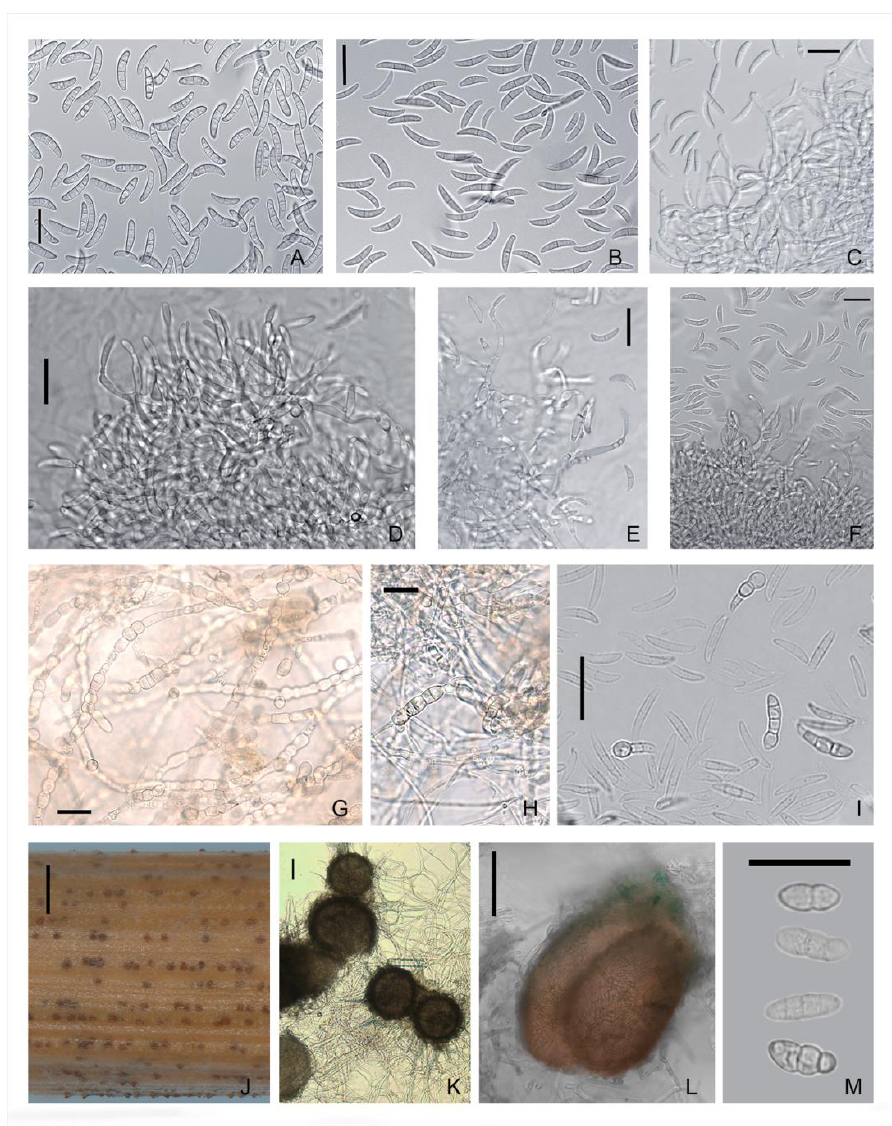
Figure 4. M. nivale : ( A,B ) conidia; ( C – F ) aggregated conidiophores with conidiogenous cells; ( G , H ) dark brown hyphal cells; (I) thick walled conidial cells; ( J – L ) ascomata; and (M) ascospores. Media: ( A – I , L,M ) PSA; ( J , K ) wheat stems. Scale bars: ( A–I , M ) 20 μm; (J) 1 mm; ( K , L ) 50 μm.